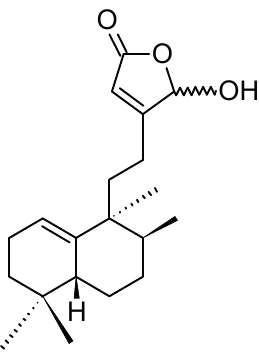
Figure 41. Echinohalimane A ( 119